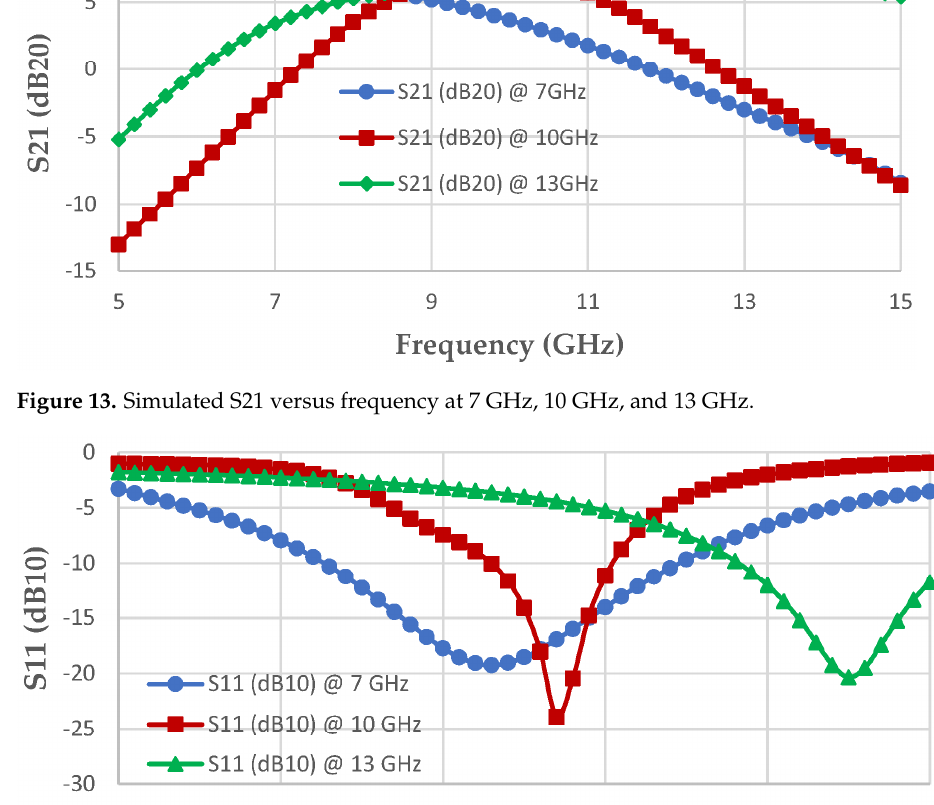
Figure 15. Full layout for the presented VGA at 10 GHz. Table 4. Comparison between the achieved specifications from the proposed tool at the three test frequencies and the required ones. Specifications Required Speci- fications at 7 GHz